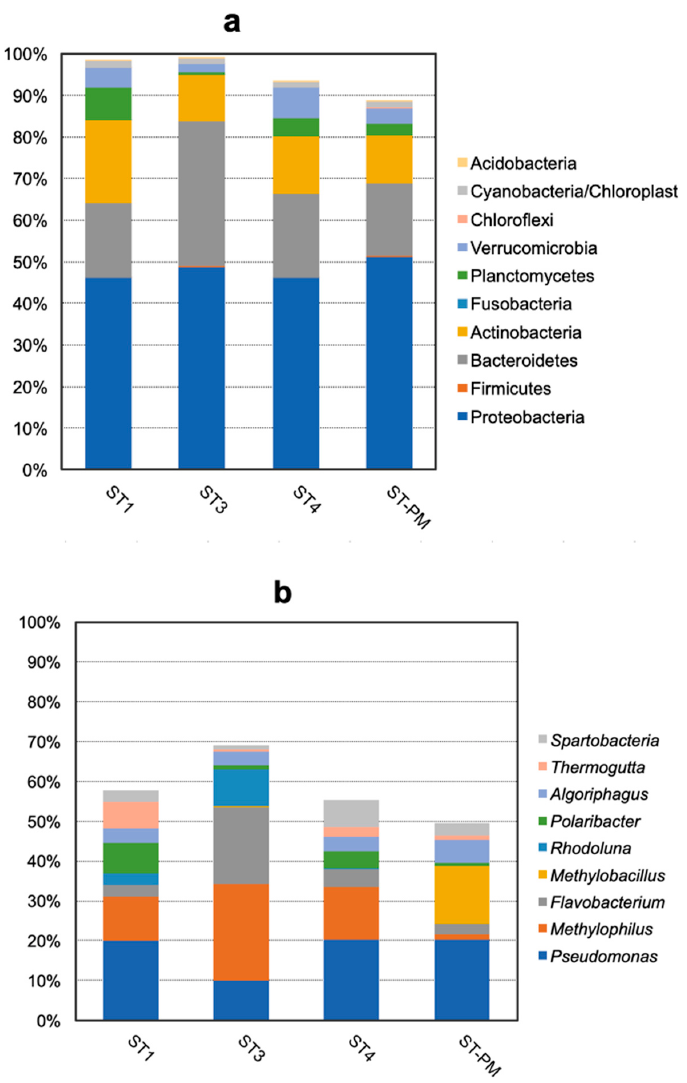
Figure 1. Distribution of the top 10 most common ( a ) phyla and ( b ) genus. ST1, ST3, ST4: water samples Litopenaeus vannamei from three different ponds; ST-PM: a water sample of Penaeus monodon .